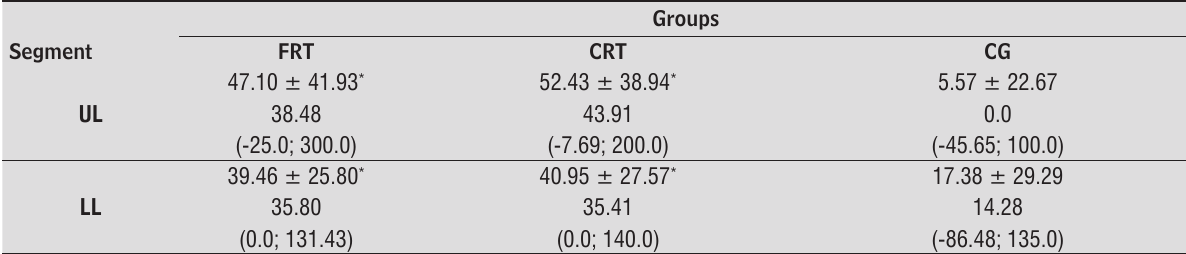
Table 3 - Mean, standard deviation, median and minimum and maximum values of percentage gain (Kg) in the 1RM test according to